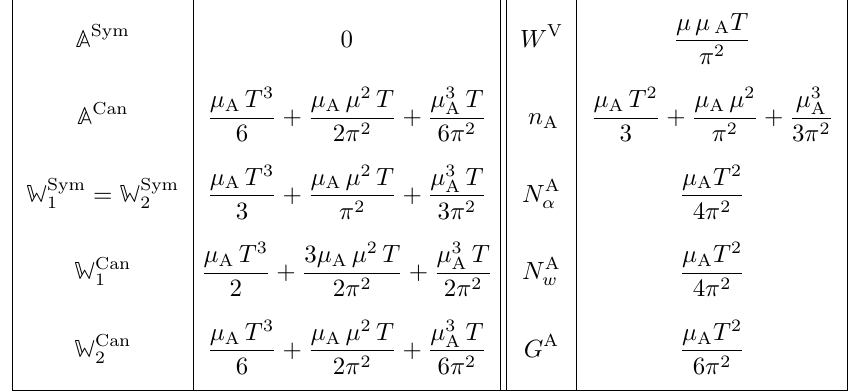
β , µ = ζ T and µ A = ζ A T . | |